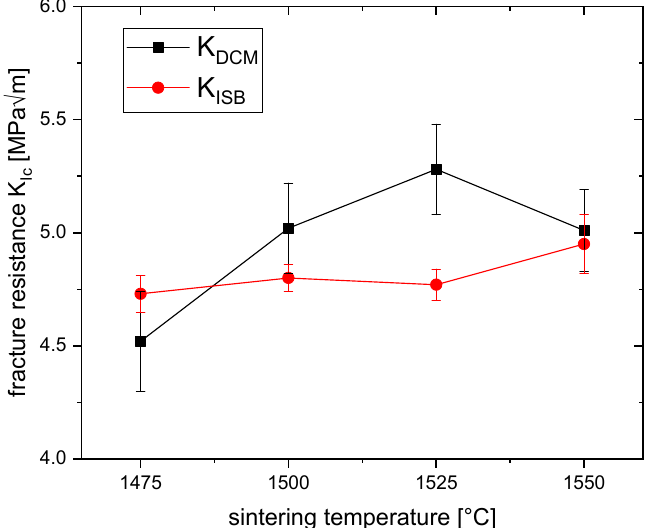
Figure 3. Fracture resistance K DCM (Evans model) and K ISB of ZTA-TiN vs. sintering temperature.